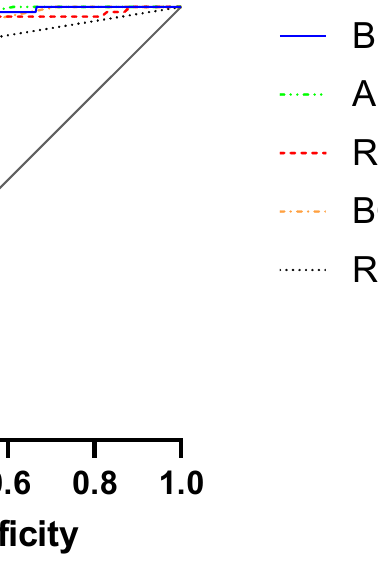
Figure 1. Receiver operating characteristic (ROC) and area under the curve (AUC) displaying the predictive value of the assessed mortality prediction scores. Table 4. Comparative analysis of prognostic models.